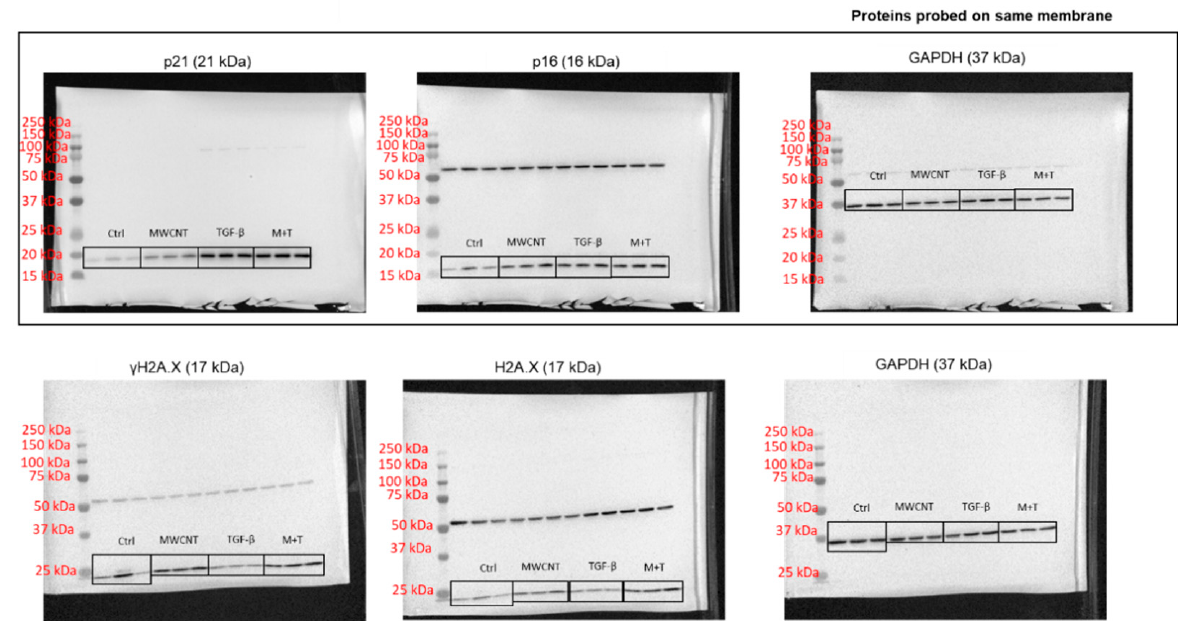
Figure A1. Full unedited gel for Figure 2